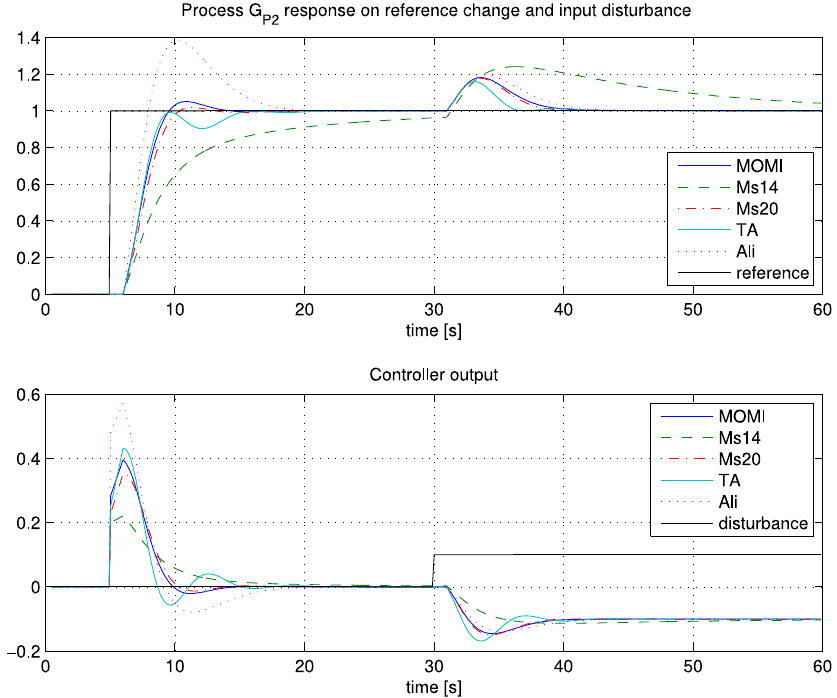
Table 7. PI controller parameters for Case 2.